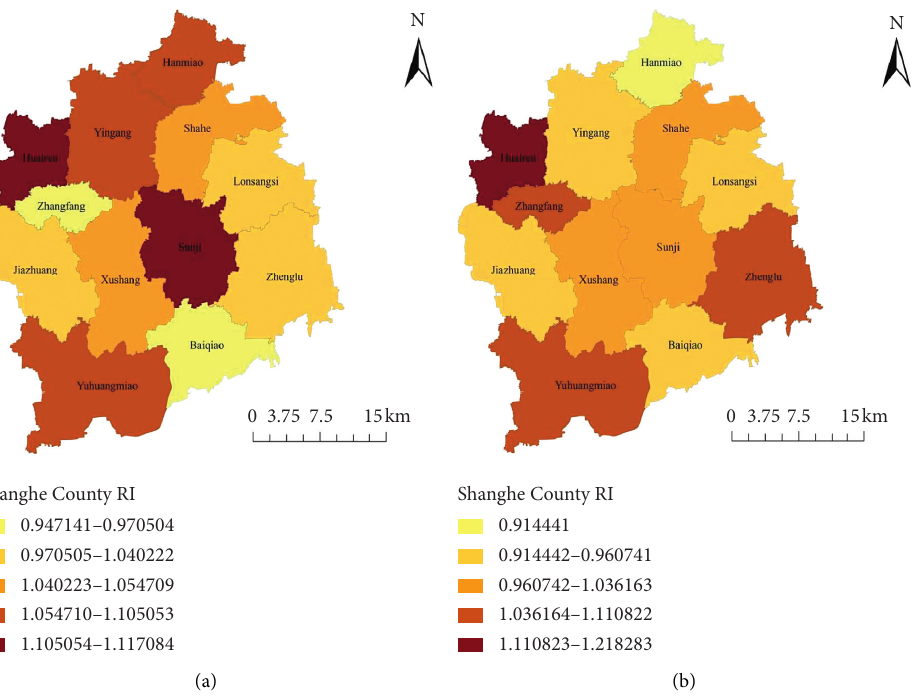
Figure 4: (a) Rurality intensity distribution of Shanghe County in 2009. (b) Rurality intensity distribution of Shanghe County in